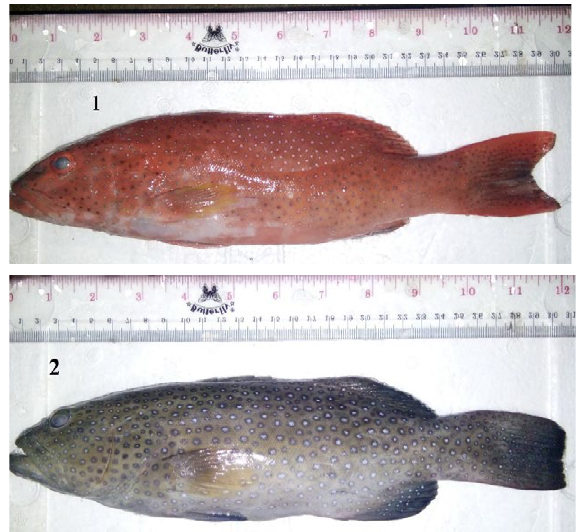
Fig. 2: Groupers caught at Wakatobi National Park (1) Plectropomus leopardus, (2) Plectropomus